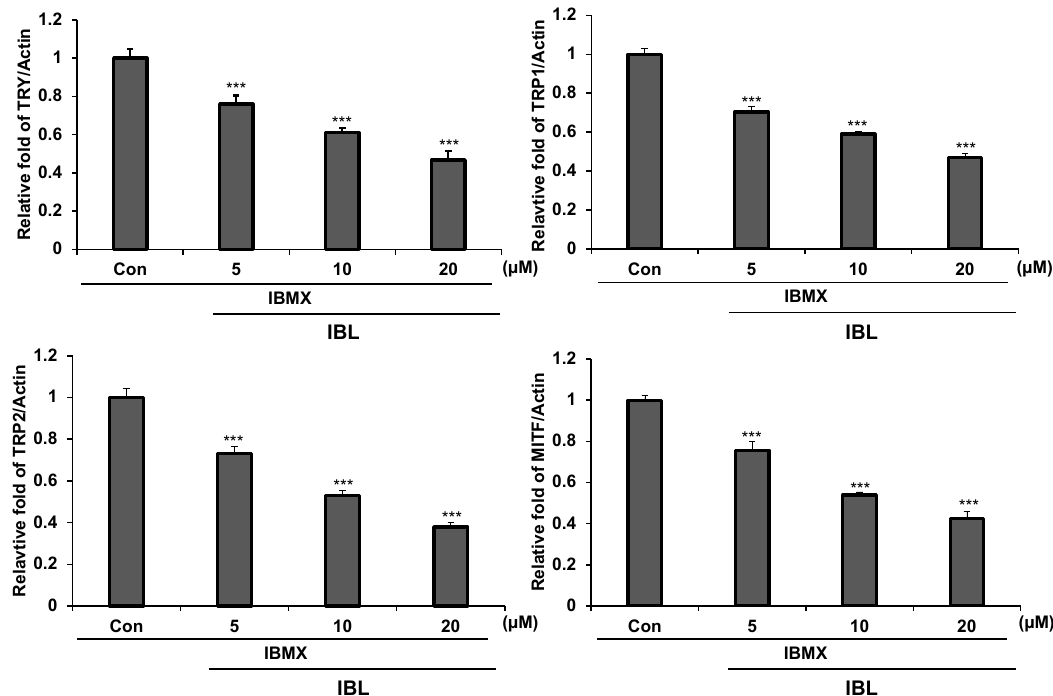
Figure 5. Inhibitory effects of IBL on whitening-related mRNA levels in B16F10 cells. B16F10 cells were stimulated with 100 µM IBMX for 48 h after pre-treatment with the indicated concentrations of IBL (5, 10, 20 µM) for 12 h. Real time-PCR was performed using gene specific primers for tyrosinase, Trp1, Trp2, and MITF, The expression levels were normalized to that of actin. Values are represented as means ± SEM. ( n = 3, *** p ≤ 0.001).